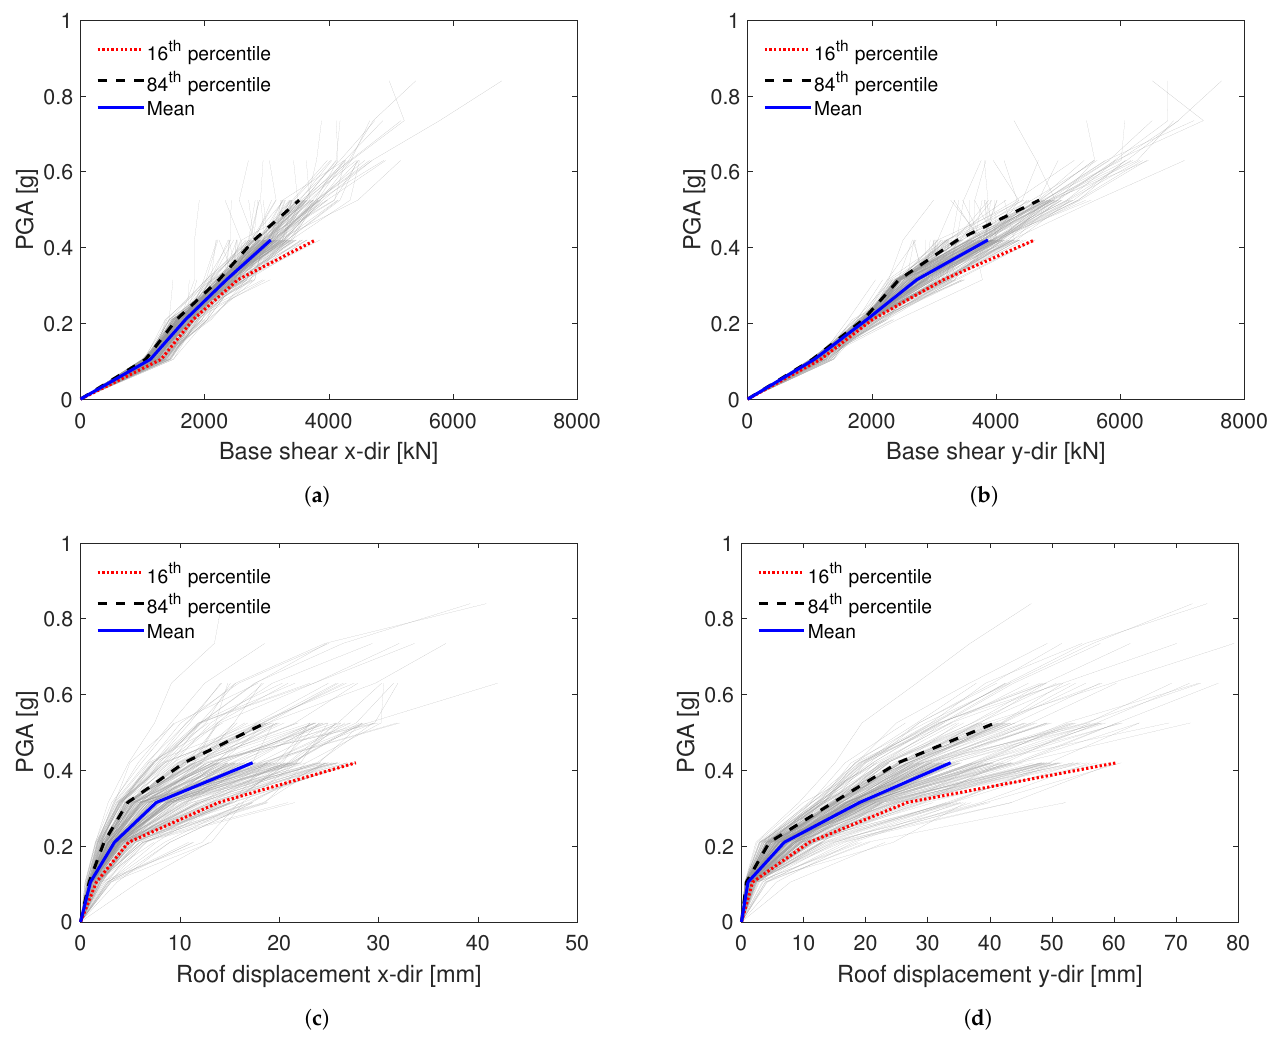
Figure 12. Holsteiner Hof model (with out-of-plane disabled and rigid connections) IDA curves displaying the maximum values of seismic demand parameters: ( a ) Total base shear in x-direction. ( b ) Total base shear in y-direction. ( c ) Average roof displacement in x-direction. ( d ) Average roof displacement in